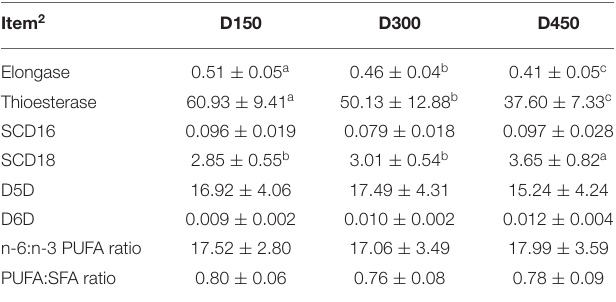
TABLE 2 | Main estimated indices of fatty acid metabolism (on the basis of fatty acid composition expressed as µ g/g of DM) in skinless breast meat during laying period (mean ± SD, n = 10) 1 .